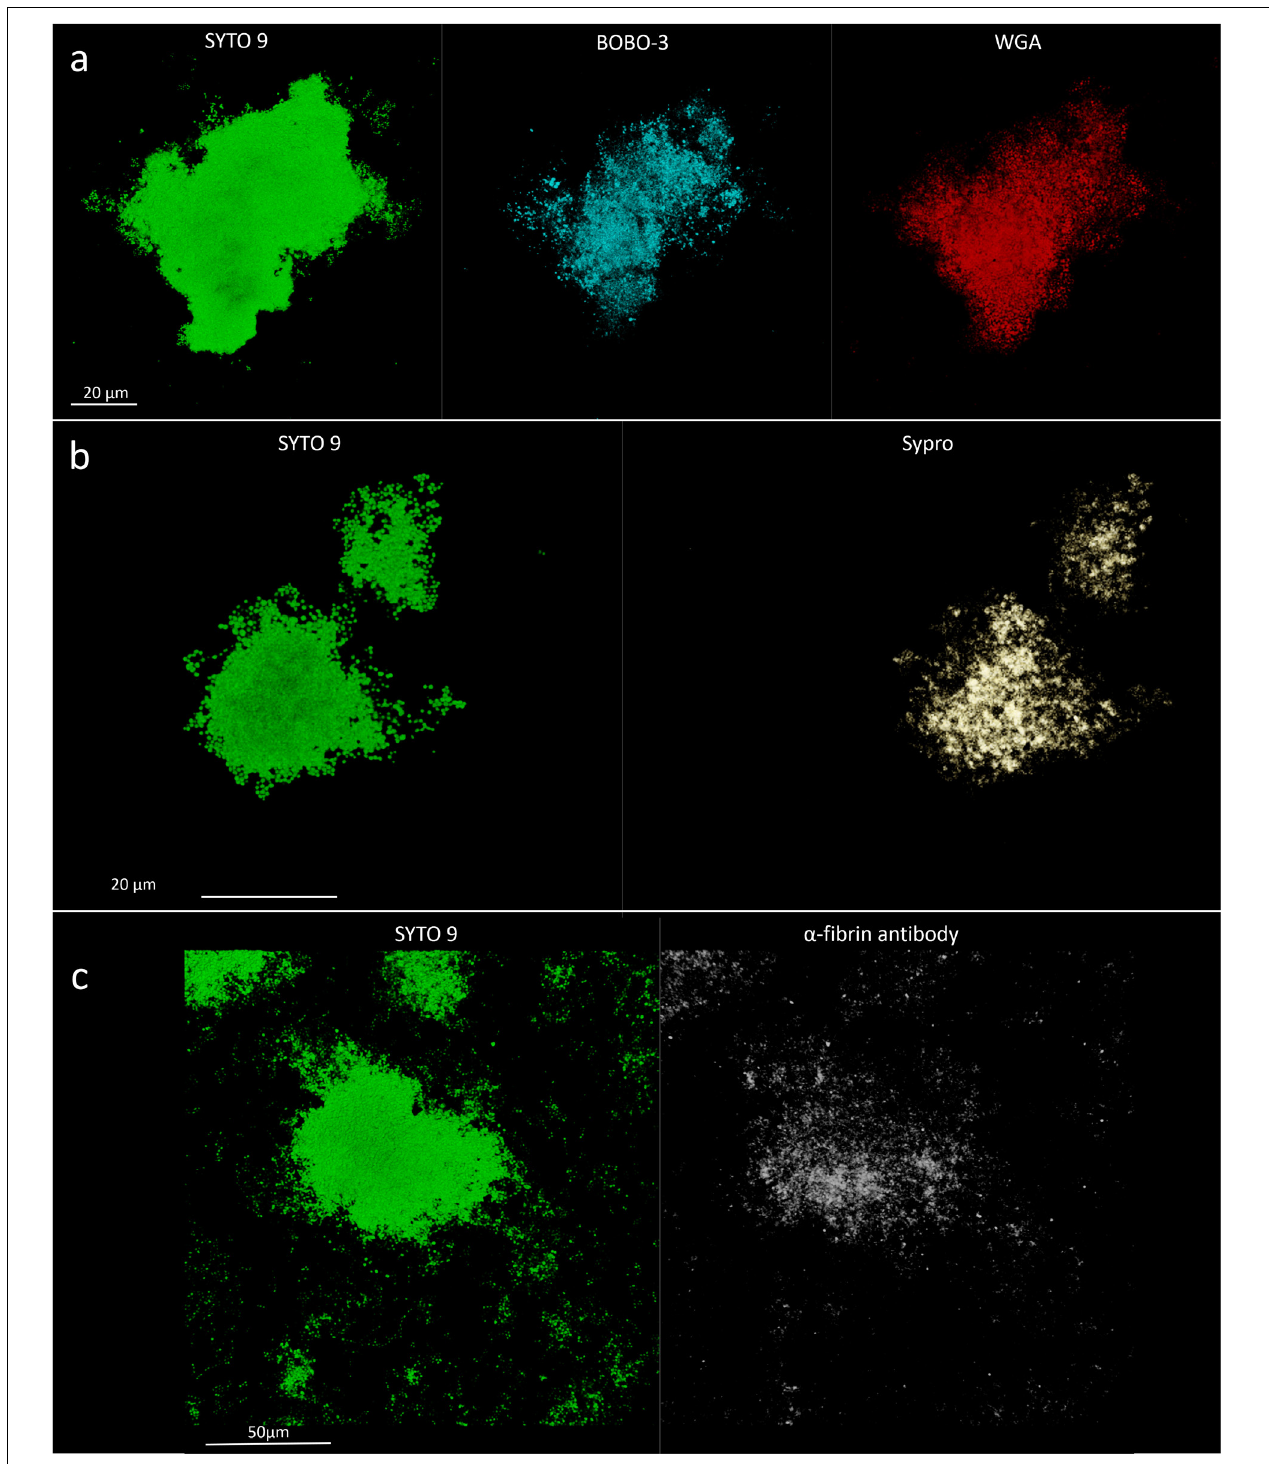
FIGURE 5 | Detection of matrix components in in vitro assays. (a) Staphylococcus aureus 1; left panel, SYTO 9 for cellular biomass; central panel, BOBO-3 for eDNA staining; and right panel, WGA stain for GlcNAc containing polysaccharides. (b) S. aureus 1; left panel, SYTO 9 for cellular biomass; right panel, SYPRO-Ruby staining. (c) Detection of fibrin incorporation in S. aureus 2 biofilm-like aggregate; left panel, SYTO 9 for nucleic acids (green); right panel, α -fibrin antibody (gray).